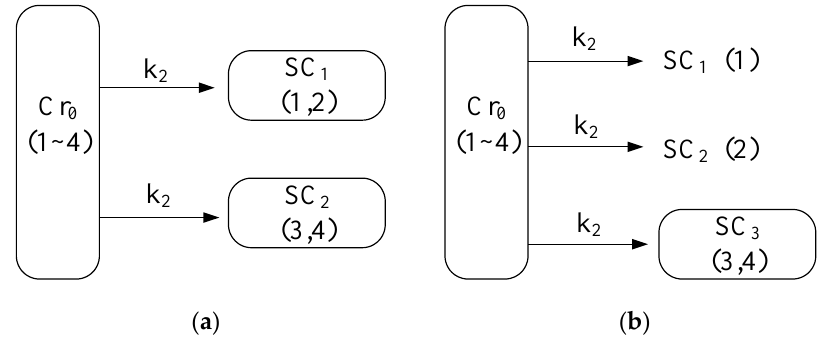
Figure 18. Cluster spanning tree and the corresponding CA. ( a ) p ˆ = 0.5; ( b ) p ˆ = 0.7 and 0.9.